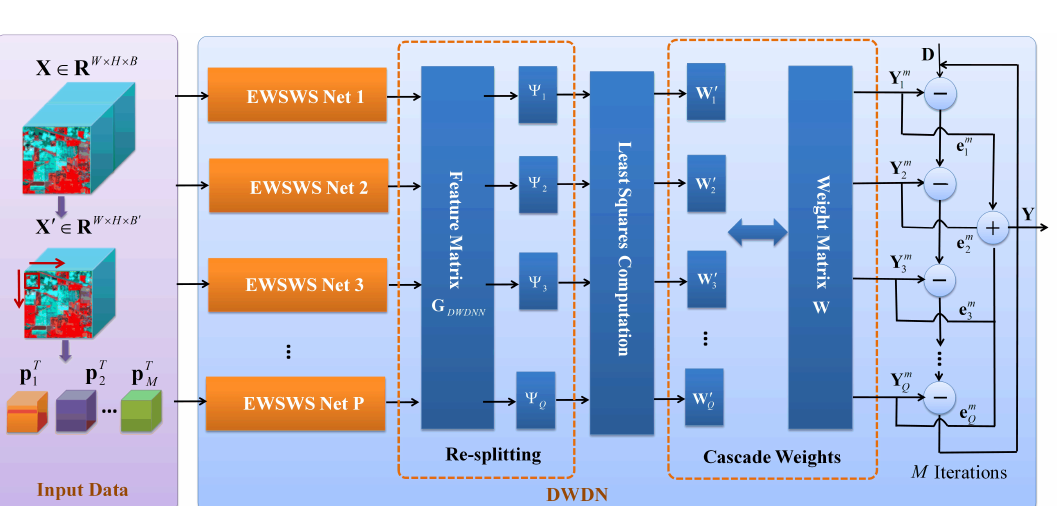
Figure 4. Dynamic iterative learning of the DWDNN. The weights are related to the combined outputs of the final EWSWS layers from the EWSWS networks. The weights’ resplitting block and iterative least squares are used to learn these weights in the fully connected